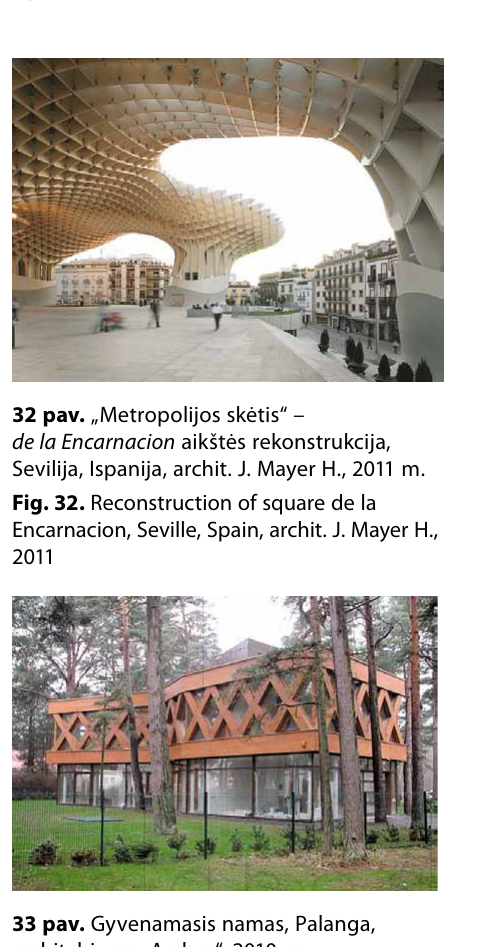
Fig. 33. House in Palanga, archit. office